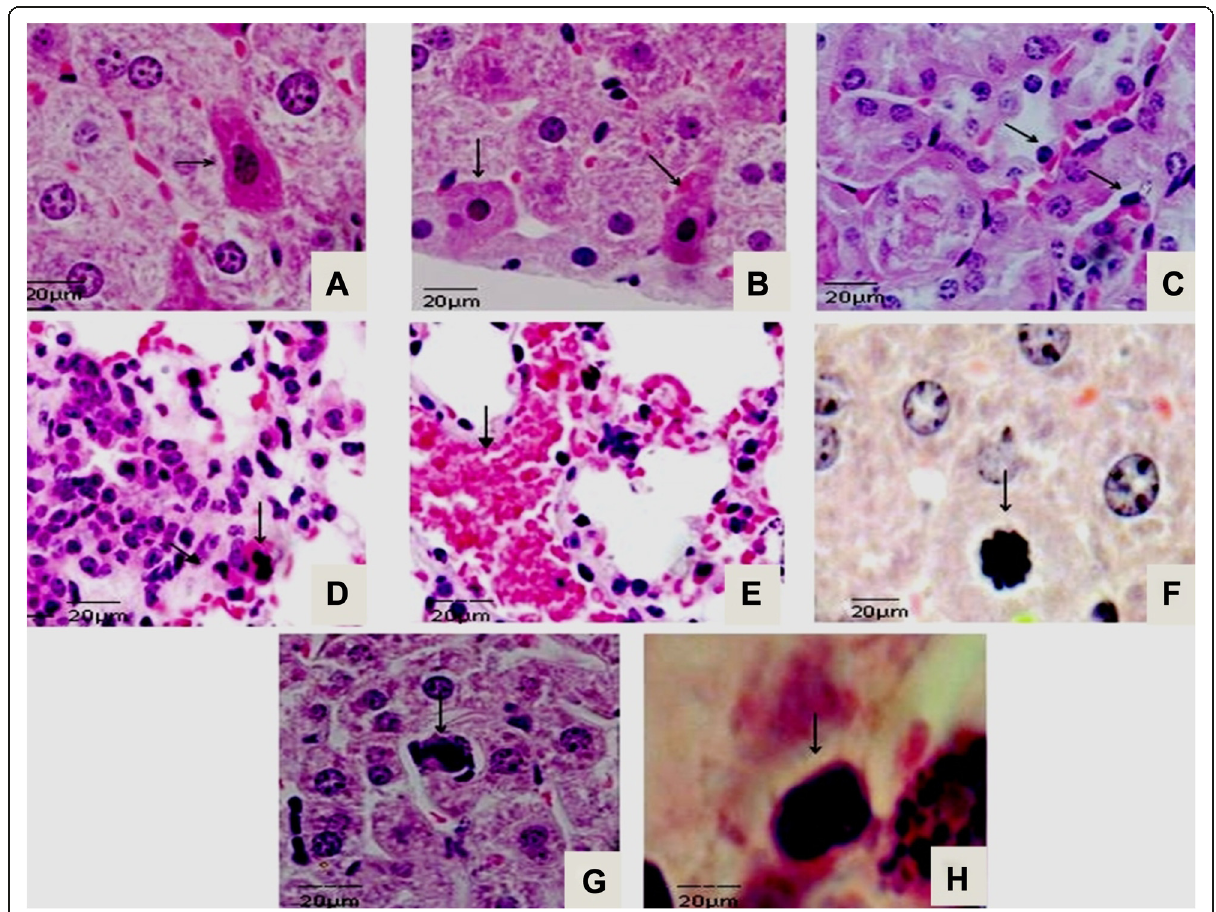
Fig. 1 Histological lesions in BALB/c infected with L. interrogans serovar Icterohaemorrhage. Shown are sections of ( a and b ) liver, ( c ) kidneys, and ( d and e ) lungs. Hepatocytes showing eosinophilic cytoplasm and nuclear condensation at 14 dpi (arrows); kidneys degeneration followed by acute tubular necrosis in cortical tubules at 21 dpi (arrow); lung tissue at 14 dpi showing diffuse inflammatory cell infiltrate close to hilum region (arrow); condensation of chromatin and apoptotic bodies observed in kidney and liver sections (arrows) (n = 5 animals). Bar: 20 μ